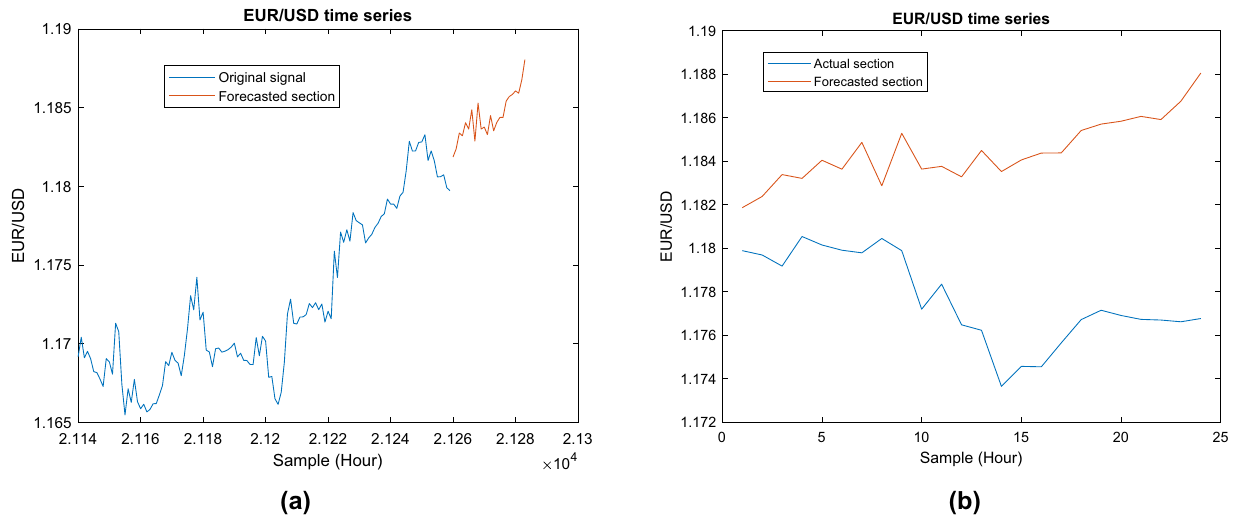
Fig. 3 a Forecasting the upcoming 24 data samples of the EUR/USD exchange rate using the apriori 120 data samples. b Comparison of the forecasted data [24 samples (hours)] with the actual data. The forecasting accuracy is weak, with a correlation coefficient of −